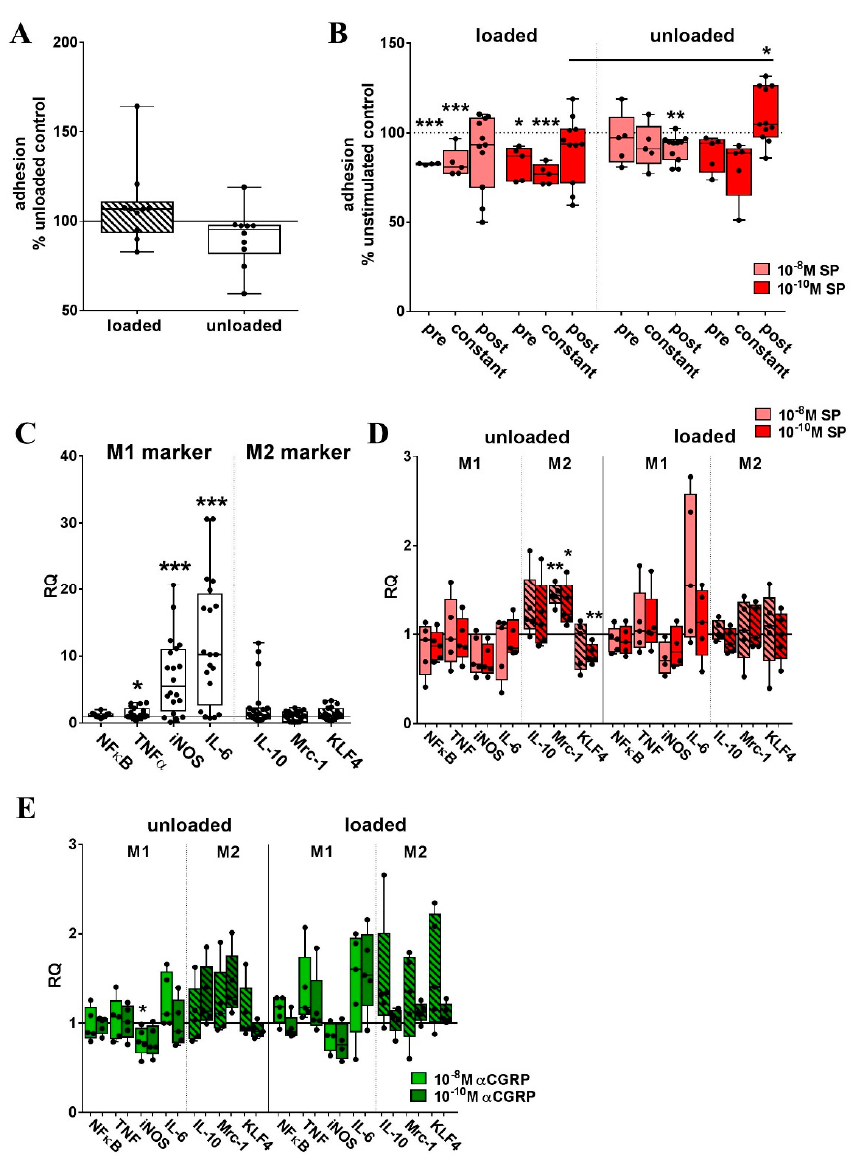
Figure 4. The impact of mechanical loading and sensory neuropeptide stimulation on adhesion and gene expression of macrophage polarization markers of RAW264.7 cells. ( A ) The graph depicts the adhesion of loaded RAW264.7 cells relative to unloaded RAW264.7 cells (set to 100%). One sample t -test * p < 0.05. n = 10; ( B ) shows the impact of stimulation with SP on adhesion of loaded and unloaded RAW264.7 in relation to the respective unstimulated cells (=100%). The graph depicts the effect of stimulation during loading ( pre ), during loading and assay (constant ) and only during assay procedure ( post ). Pre, constant n = 5, post n = 11. One sample t -test * p < 0.05, ** p < 0.01; *** p < 0.001; ( C ) Analysis of gene expression of M1 and M2 macrophage phenotype markers in loaded RAW264.7 cells in relation to non-loaded cells (calibrator, RQ = 1) analyzed by quantitative real-time PCR; ( D , E ) Gene expression of macrophage phenotype markers in loaded and unloaded RAW264.7 cells stimulated with SP ( D ) and α CGRP ( E ) in relation to respective unstimulated cells (calibrator, RQ = 1). Normalizer: GAPDH . One sample t -test * p < 0.05; ** p < 0.01; *** p < 0.001. unstimulated n = 20, stimulated n = 5. SP—substance P, α CGRP—alpha- calcitonin gene-related peptide, RQ—relative quantification, PCR—polymerase chain reaction, GAPDH — glyceraldehyde 3-phosphate dehydrogenase , NF κ B — nuclear factor kappa light chain enhancer of activated B cells , TNF α — tumor necrosis factor alpha , iNOS — inducible NO synthase , IL-6 — interleukin 6 , Mrc-1 — mannose receptor 1 , KLF4 — krüppel-like factor